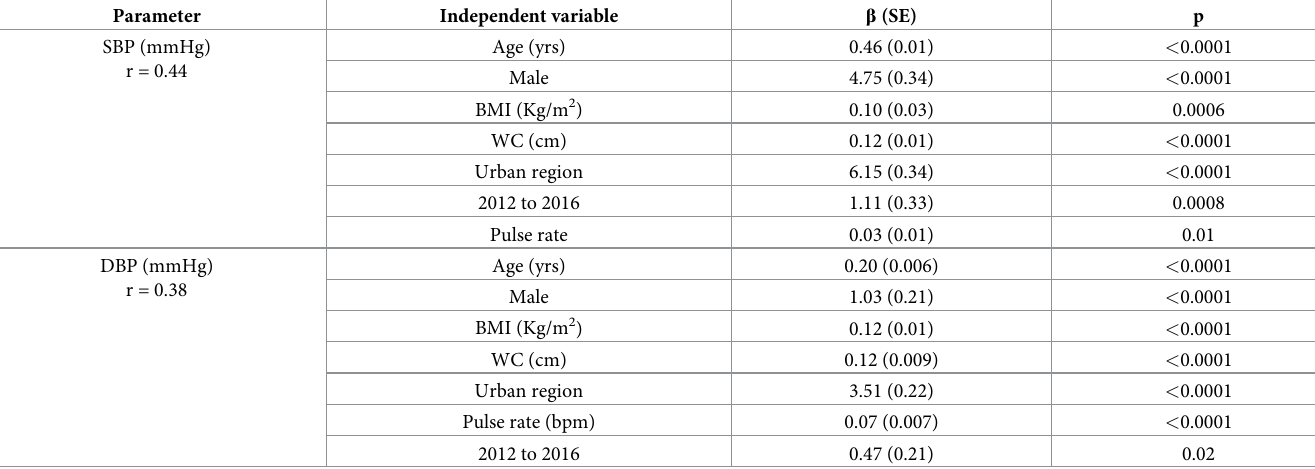
Table 4. Multivariate linear regression analysis of systolic blood pressure and diastolic blood pressure according to the risk factors (stepwise